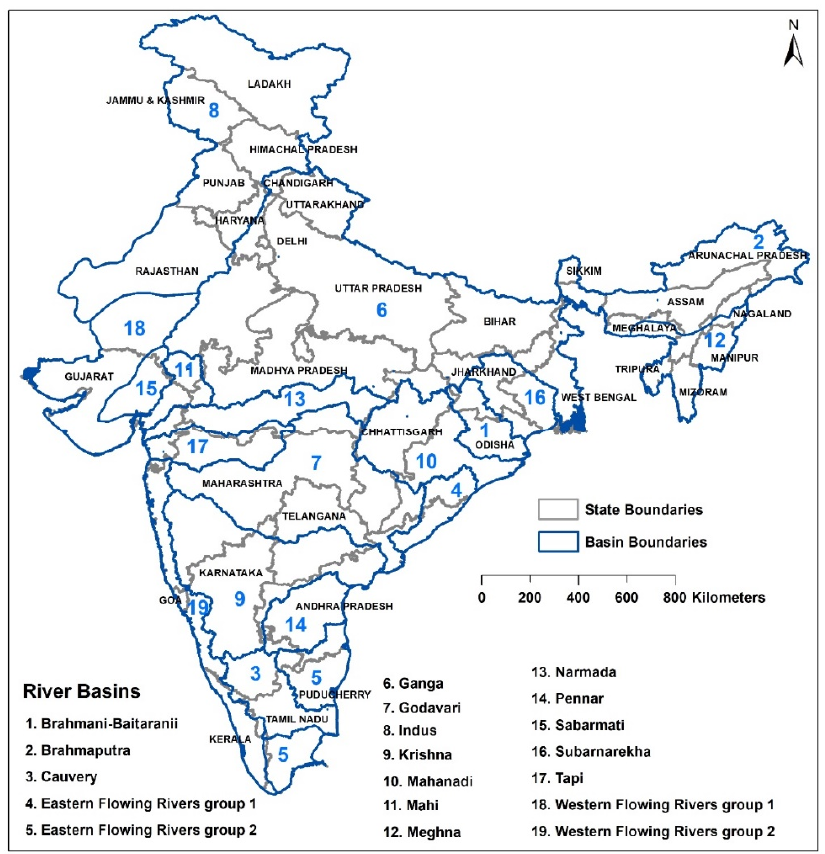
Figure 1. State and river basins of India.